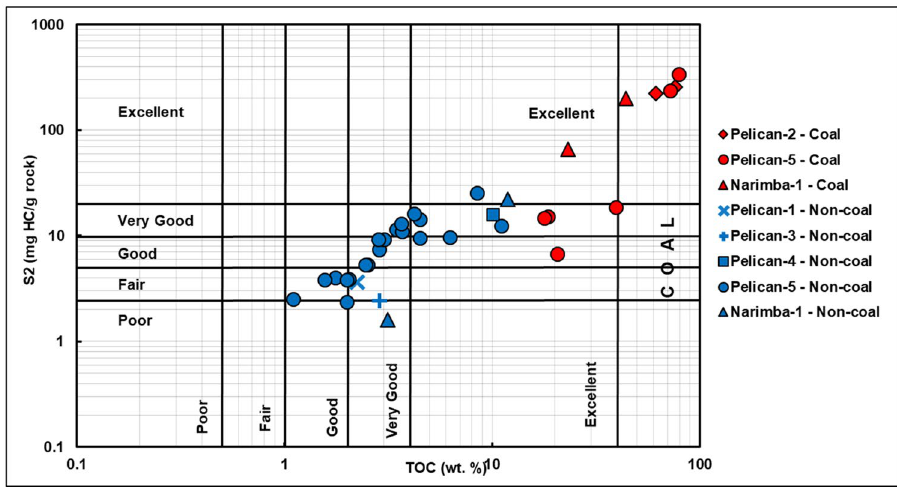
Fig. 6 S 2 versus TOC cross- plot for quality and quantity of organic matter (Espitalié et